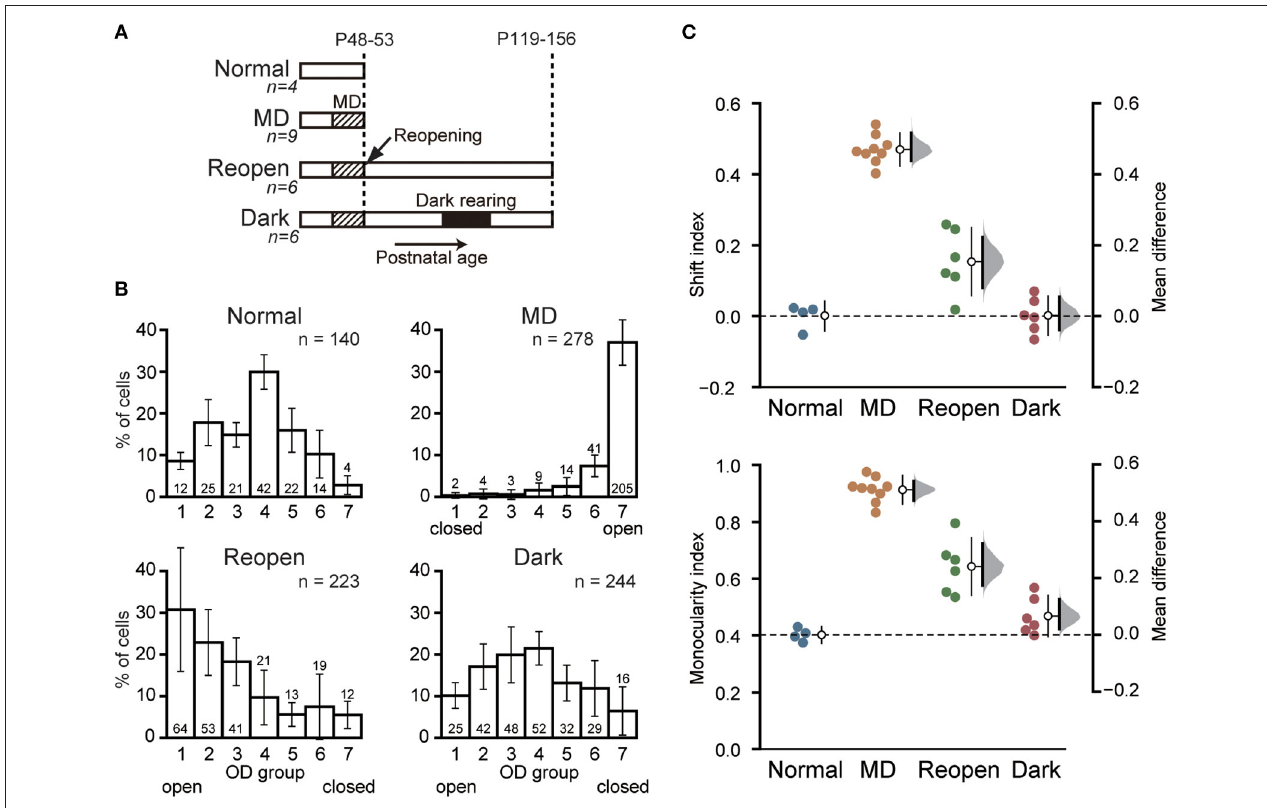
FIGURE 1 | Dark rearing promotes the recovery of cortical responses to the closed eye. (A) Schematic illustration showing the experimental procedures and schedule of the four animal groups. Normal: Normal young animals. Electrophysiological recording was made at P48–53. MD: Young animals with monocular deprivation (MD). Recording was made after 6–7 days of MD. Reopen: Control animals that were raised in binocular conditions after MD. Recording was made at adolescence. Dark: Animals that were raised in binocular conditions after MD and reared in darkness for 10 days at adolescence. Recording was made 12–20 days after dark rearing. The number of animals is given below each group name. (B) Ocular dominance (OD) of the primary visual cortical neurons in each animal group. The closed eye is indicated below the OD score. Each histogram shows the mean and SD of all animals in each group. The number of neurons in each OD score is described at each column. The total number of neurons is indicated at top-right of each histogram. Data of Normal and MD groups were obtained in our previous study (Morishima et al., 2013 ). (C) Comparison of OD distribution among animal groups. Each symbol represents the shift index (top) and the monocularity index (bottom) of individual animals. The open circles with thin vertical bars indicate the mean and SD of each group. The thick vertical bars represent the 95% confidence interval of mean difference with a bootstrap sampling distribution plotted on the right axes.